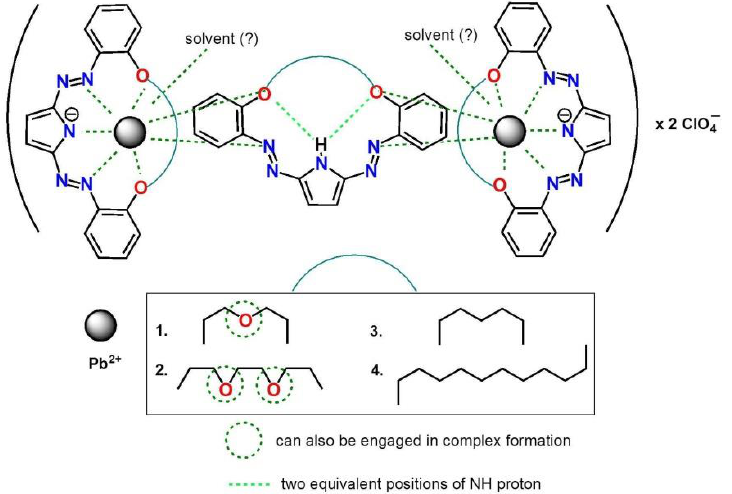
Figure 6. Proposed, simplified model (as triple-decker complex) of lead(II) binding by diazocrowns